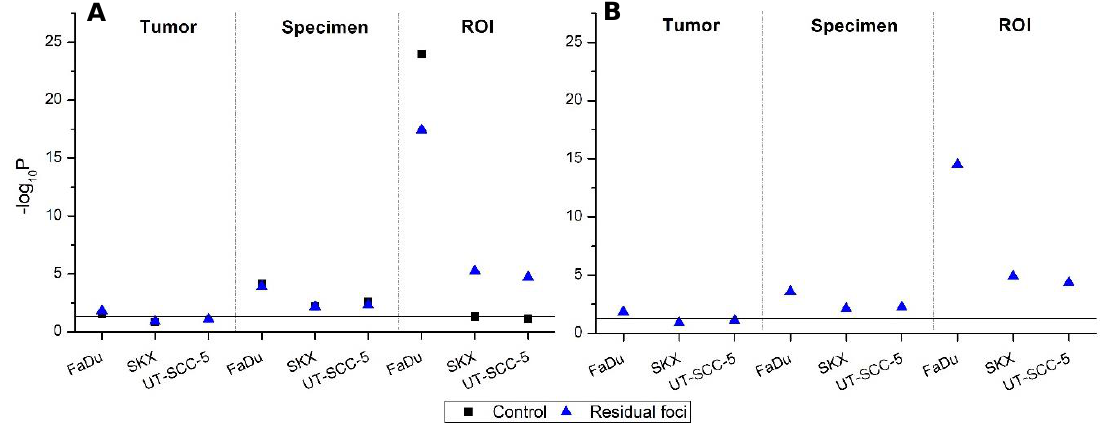
Figure 4. Heterogeneity of corrected foci (cfoci, A ) and normalized foci (nfoci g , B ) for the ex vivo set-up determined by a linear mixed-effects model (LMEM). Scatter plot of −log 10 P value according to the analysis chain of LMEM for cfoci ( A ) and nfoci g ( B ) in three tumor models (black-square: control, blue-triangle: residual foci). No fixed effect was defined; tumor, specimen, and ROI were set as random effects. cfoci represents the ratio of foci number and nucleus area of an individual cell multiplied by mean nucleus area of the corresponding tumor, whereas nfoci is cfoci of individual nuclei normalized by the mean cfoci of unexposed tumors (for details, see Section 4). Solid lines indicate the significant threshold ( p = 0.05, above the line: p < 0.05). Exact p values are given in Supplementary Tables S5 and S6.